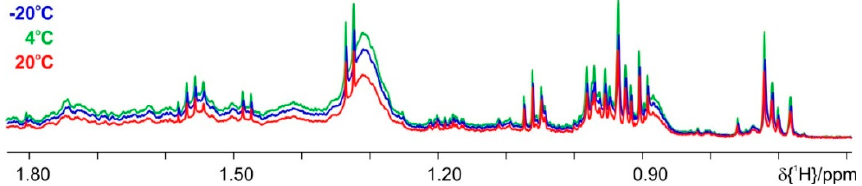
Figure 7. Influence of extraction temperature. Comparison of proton spectra, where the extraction performed at − 20 °C is given in blue, the 4 °C extraction in green and the one at +20 °C in red color. As the application of this protocol allows fulfilling all the requirements, we have evaluated its performance by comparing the NMR spectra of the two phases. After phase separation, the chloroform phase is measured and plotted against the aqueous phase (Figure S5). It confirms our expectation that lipids would predominantly reside in this phase.